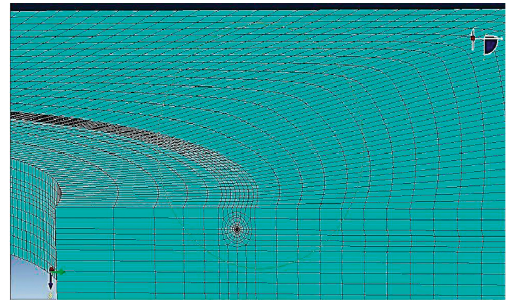
Figure 24: Location of yielding in plate.